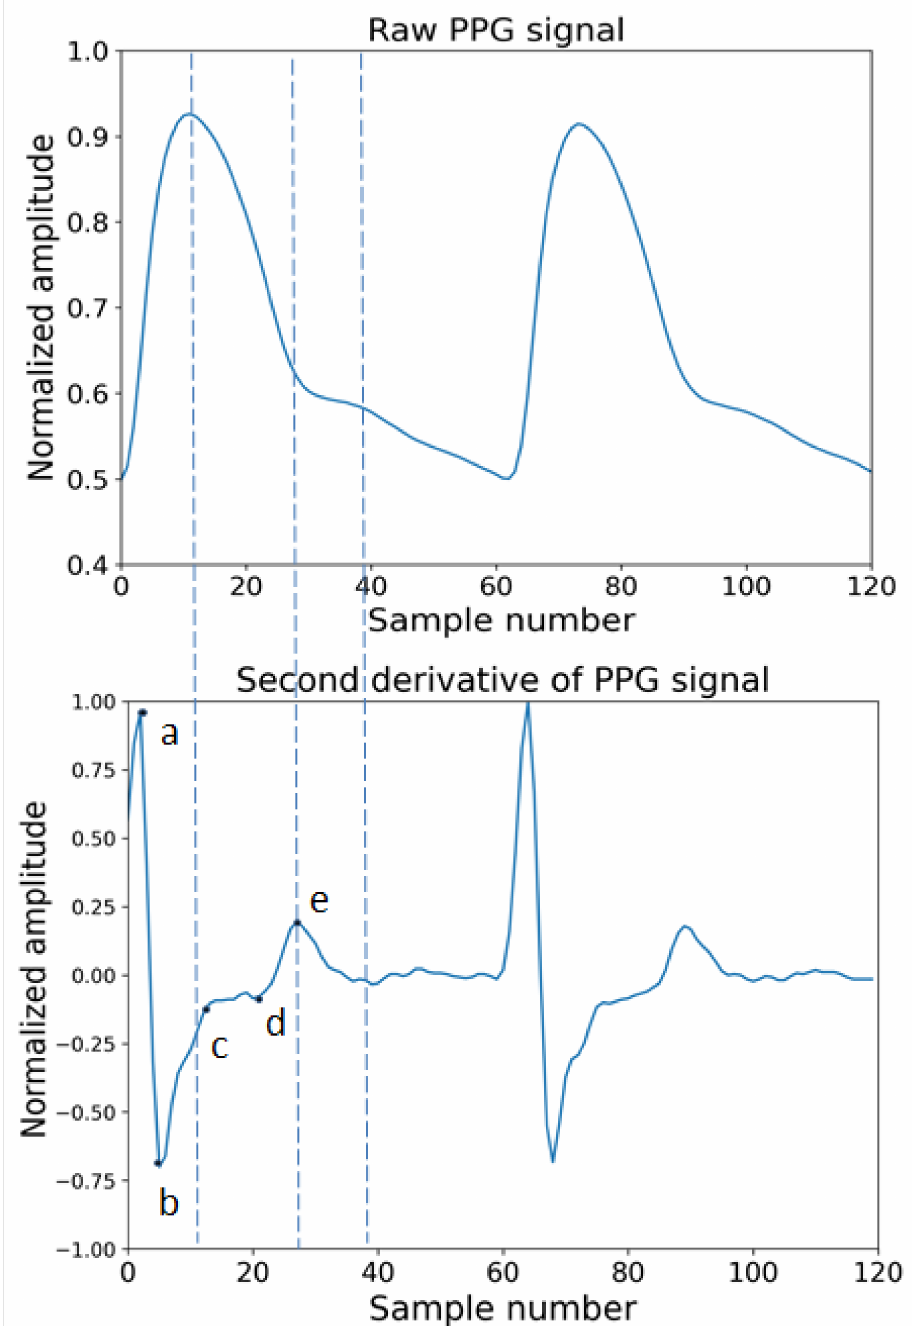
Figure 6. Original raw PPG wave and second derivative of PPG